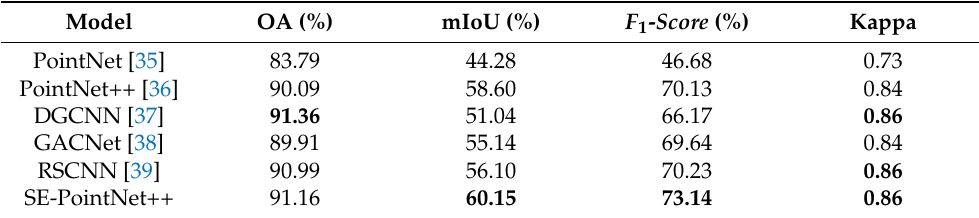
Table 4. A comparative point cloud classification results of our SE-PointNet++ with other five established deep learning modules under three test areas